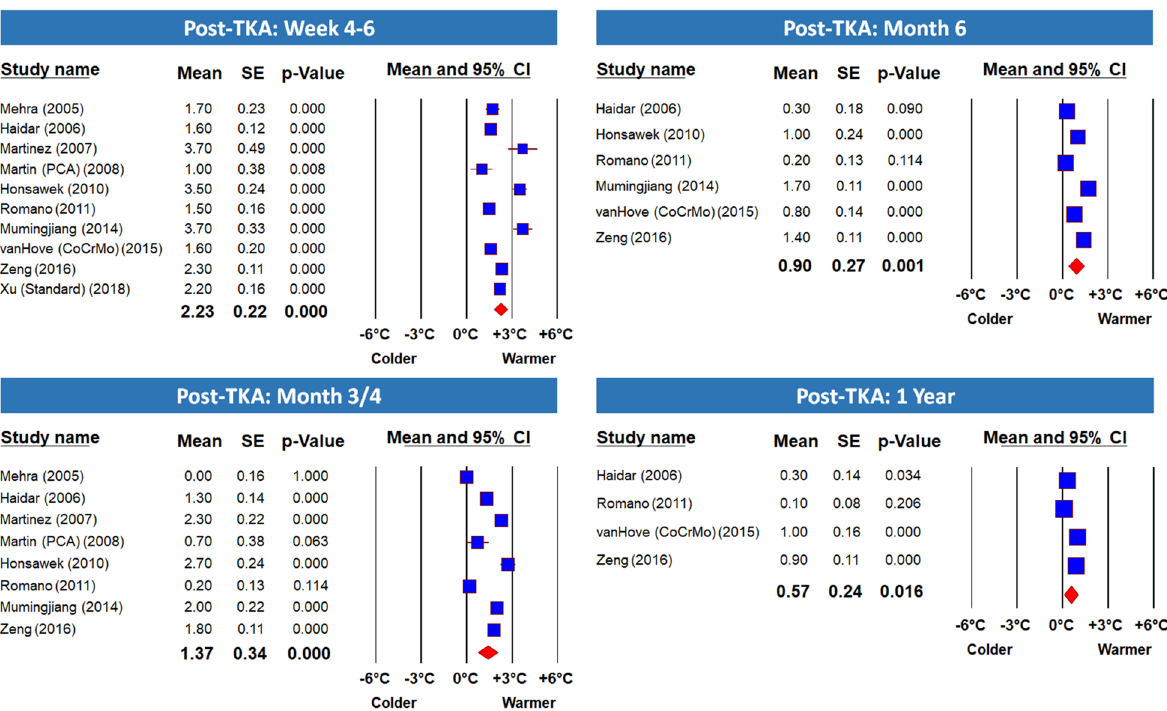
Figure 4. Meta-Analysis Forest Plots of ΔST at Medium and Long-Term Follow Ups. This panel presents Forest plots of ΔST from 4 to 6 weeks to 1 year post TKA. See details in the previous figure. Here too note that the operated knee was significantly warmer than the non-operated knee at all time points—even 1 year